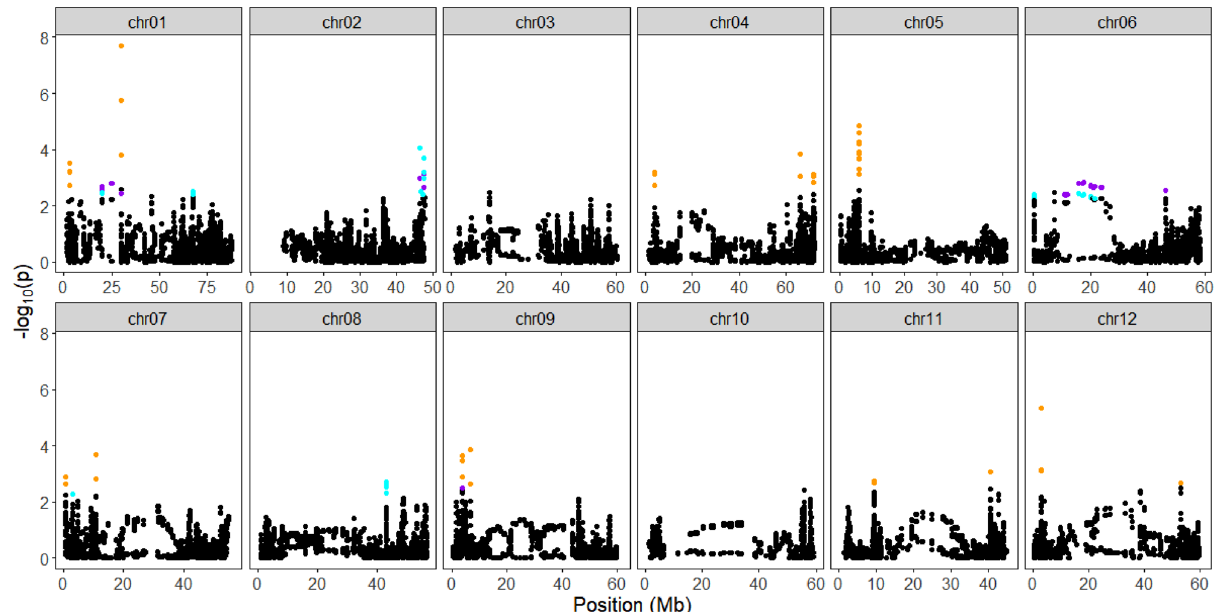
Figure 9. Distribution of standardized XP-EHH scores between three groups of potatoes using rehh R package 75 . Significant SNPs above 1% false discovery rate (FDR) threshold are colored according to groups (XP-EHH chirpru vs red = orange; XP-EHH chipru vs rn = purple; XP-EHH red vs rn =